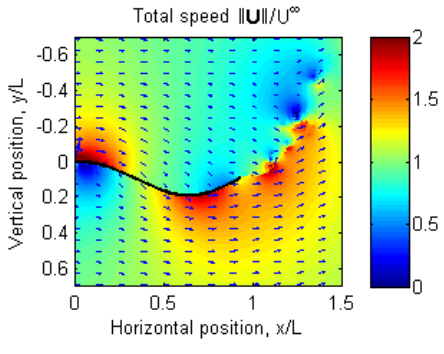
Fig. 11. Instantaneous flow field around the membrane at